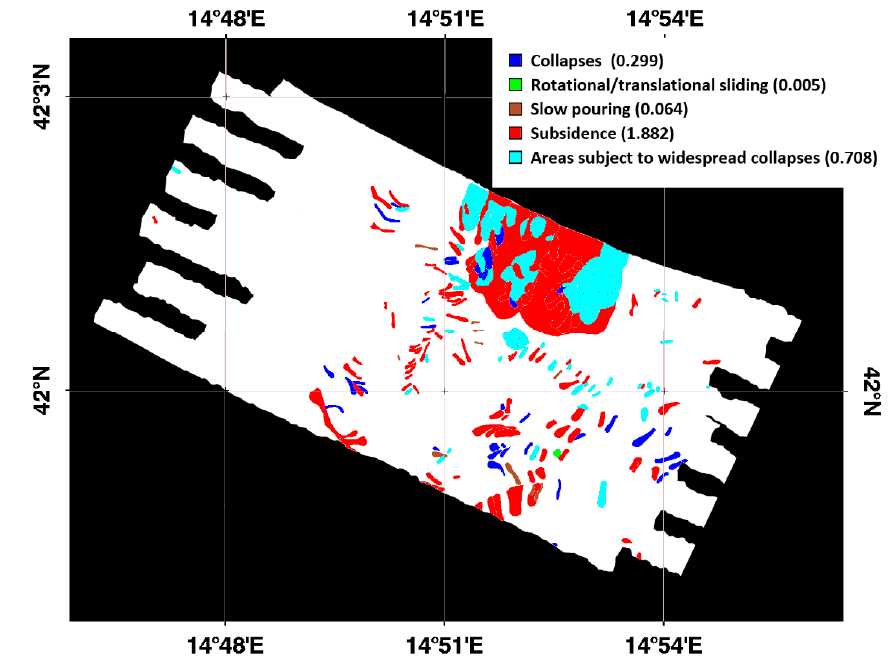
Figure 5. Landslide types occurring in the study area from the landslide catalog [58], in the legend the colors represent the different landslide types and the area extension is expressed in km 2